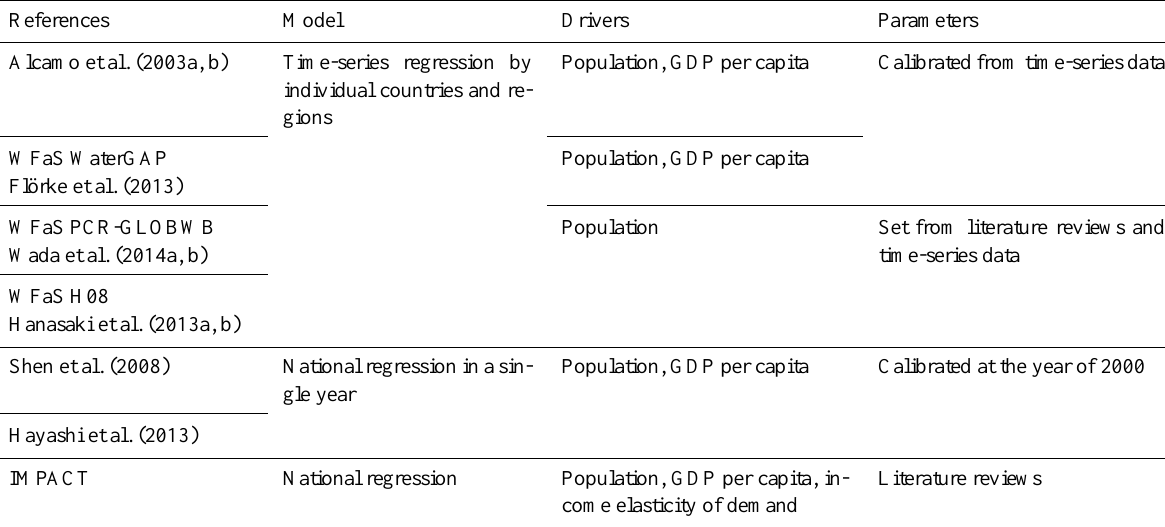
Table 3. Summary of domestic water withdrawal estimation models in earlier